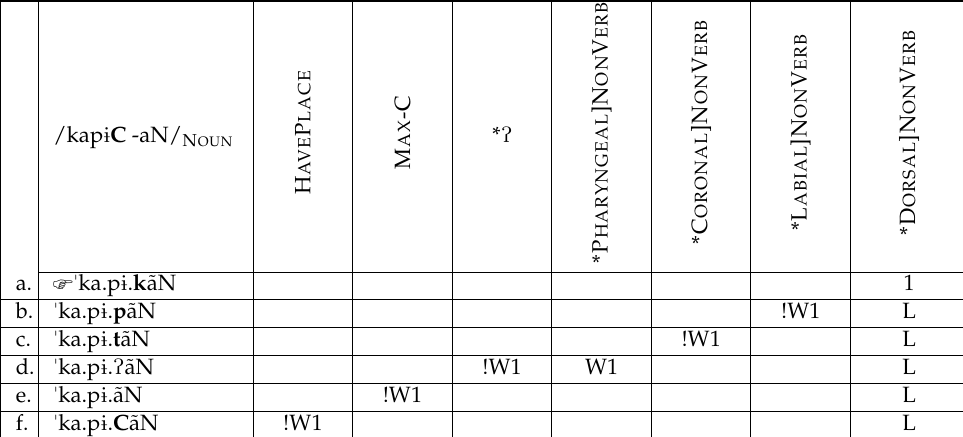
Table 4. /kap ɨ C -aN/ → [ ˈ ka.p ɨ . p ãN] ‘alligator’ (/N/form)—Capanahua. Table 3. /kap 1 C -aN/ → [ " ka.p 1 . k ã N] ‘alligator’ (/-N/form)—Shipibo-Konibo.